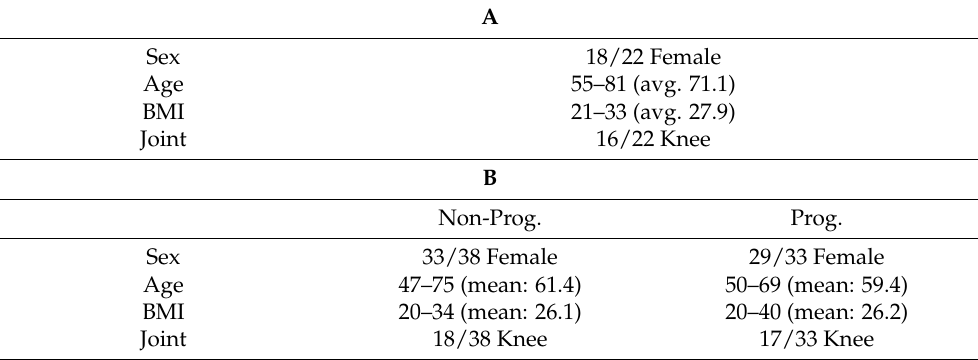
Table 1. Sample characteristics RAAK ( A ) and GARP ( B ); (non-prog: non-progressors; prog: